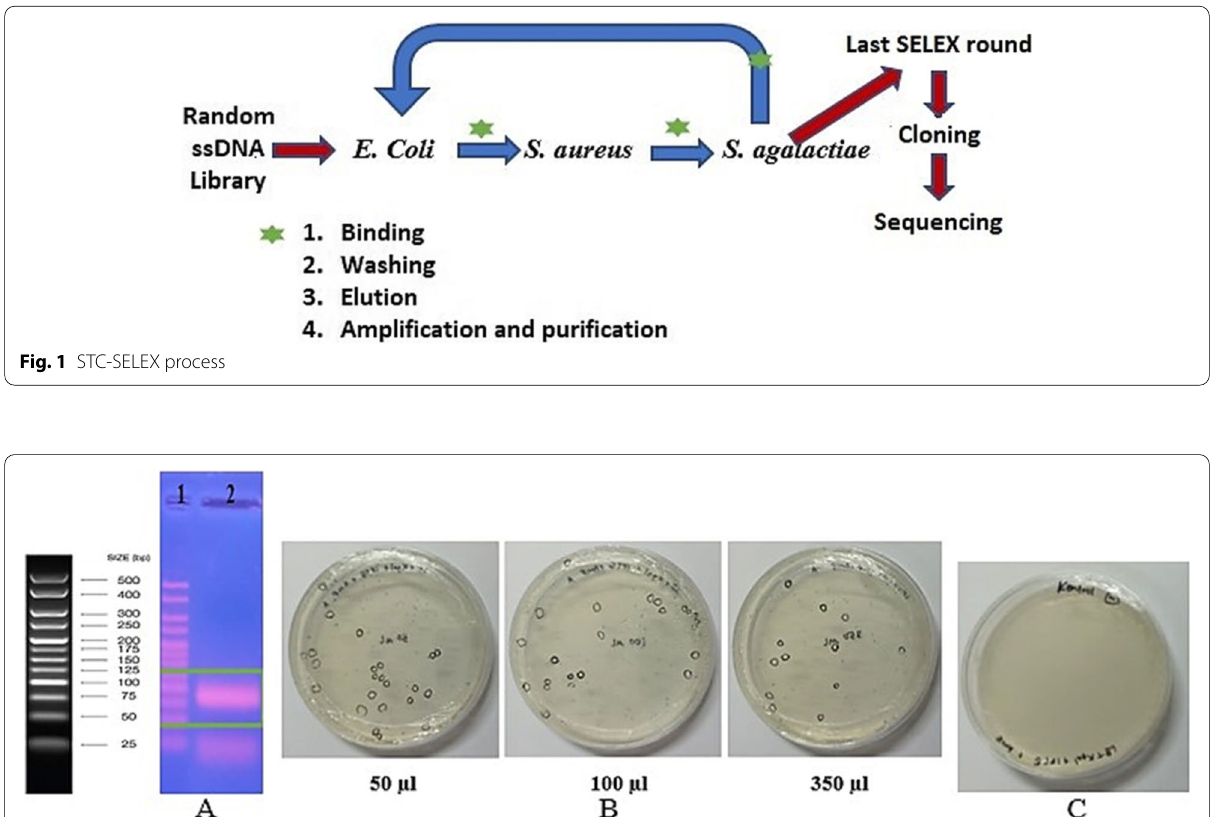
Fig. 2 Preparation of insert and the results of transformation to E. coli DH5α. A 1 Marker. 2 Insert (DNA aptamer pool SELEX 15); B Transformed colony. C Negative